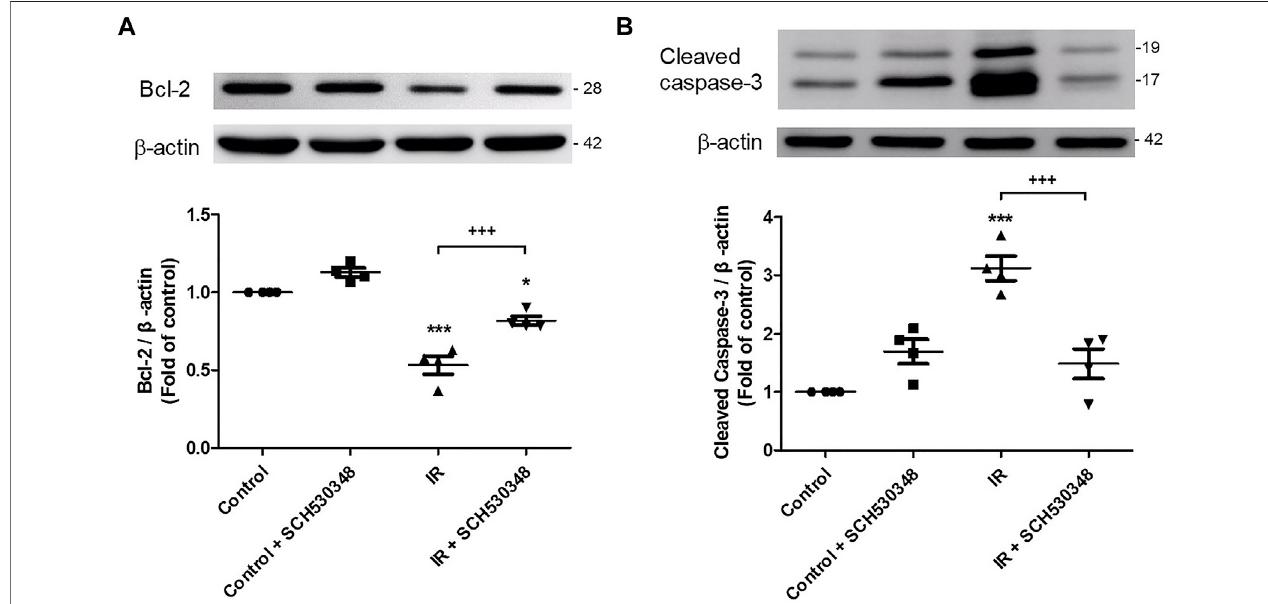
FIGURE 7 | SCH530348 reduced IR-induced lung apoptosis. Western blot analysis of (A) Bcl-2 and (B) cleaved caspase-3 protein expression in lung tissue. β -actin served as a loading control. Representative blots are shown. IR signi fi cantly decreased Bcl-2 and induced cleaved caspase-3 protein expression in lung tissue. SCH530348 treatment signi fi cantly reversed these IR-induced apoptotic effects. The data are expressed as the mean ± SD ( n (cid:1) 4 per group). * p < 0.05, *** p < 0.001, compared with the control group; +++ p < 0.001, compared with the IR group.